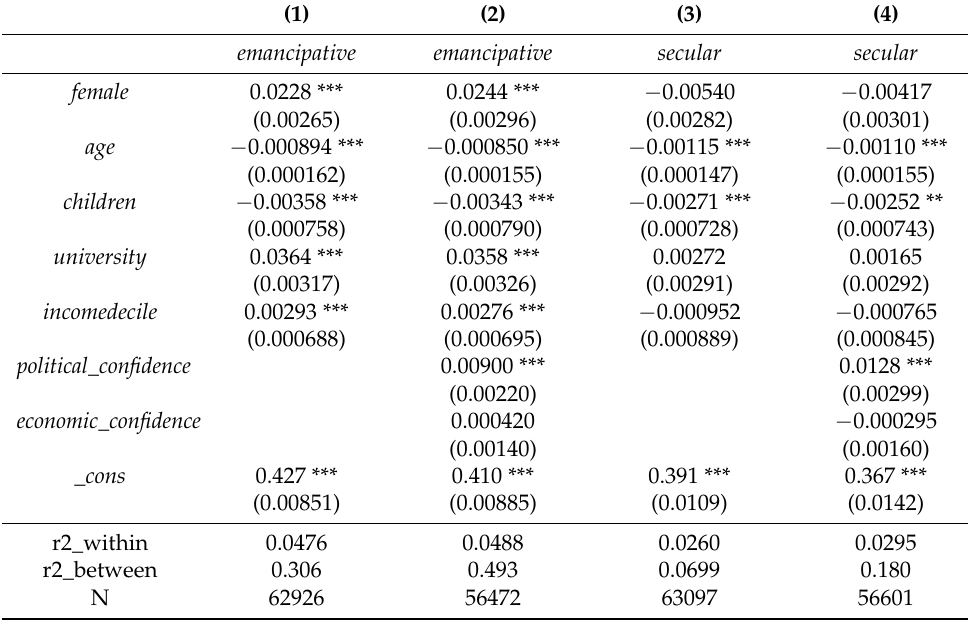
Table 4. Results of the micro-level regression